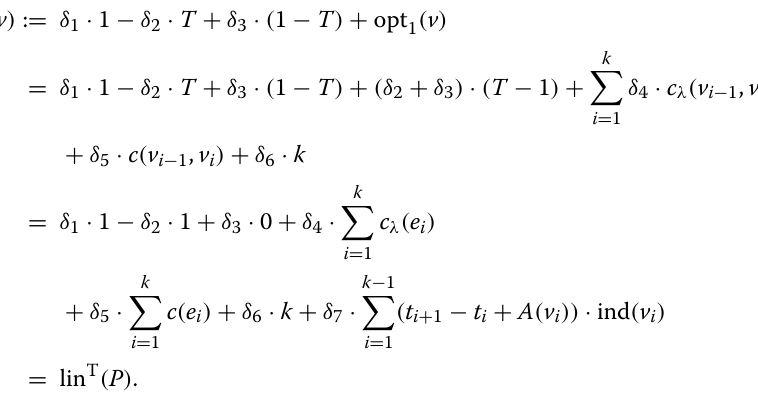
Algorithm 1 finds in modDijkstra the path P (cid:8) , adds ( opt